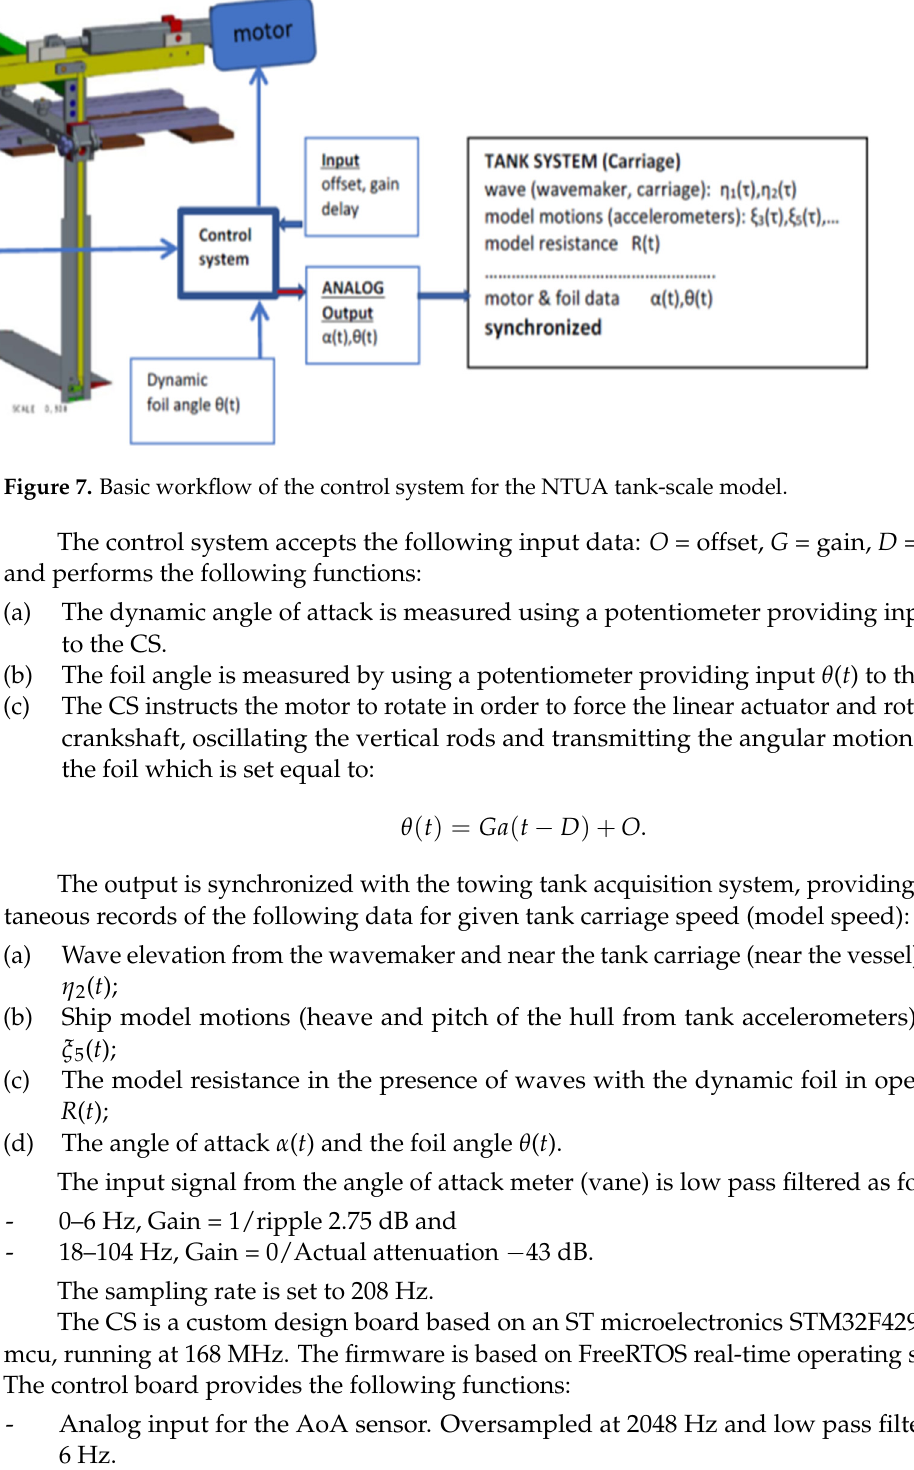
flapping thruster, and determination of motions and total resistance.